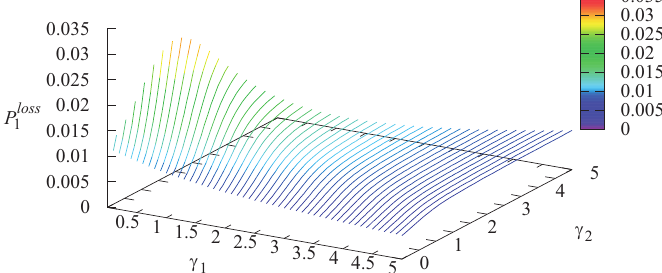
Figure 6. Dependence of the probability P loss γ 1 and γ 2